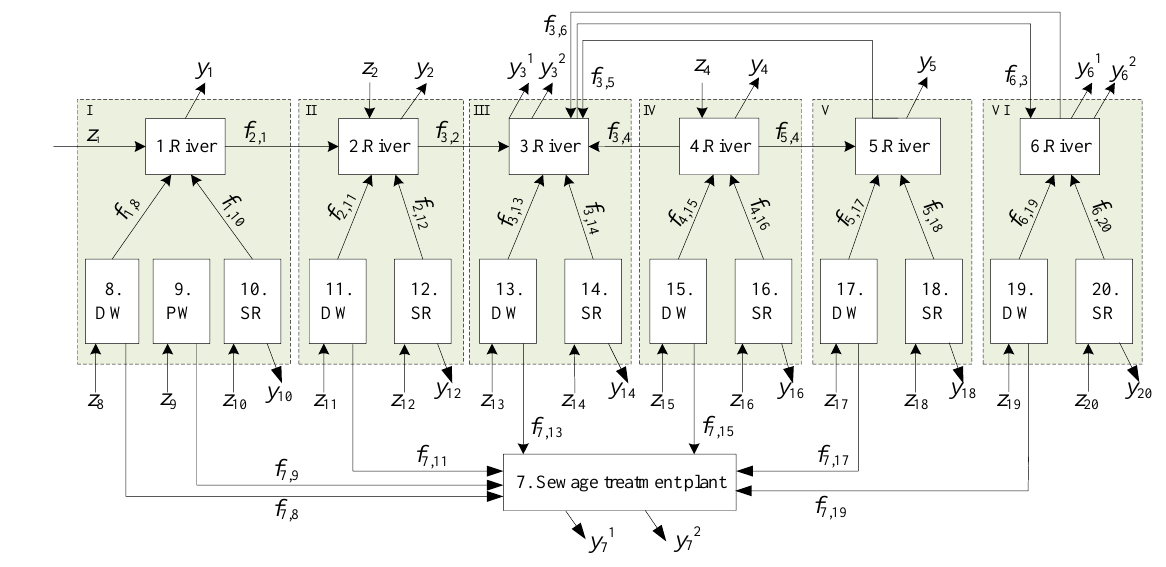
Figure 2. Sketch map of the process flow diagram for the water pollutant metabolism in sub-basin in Fuzhou.